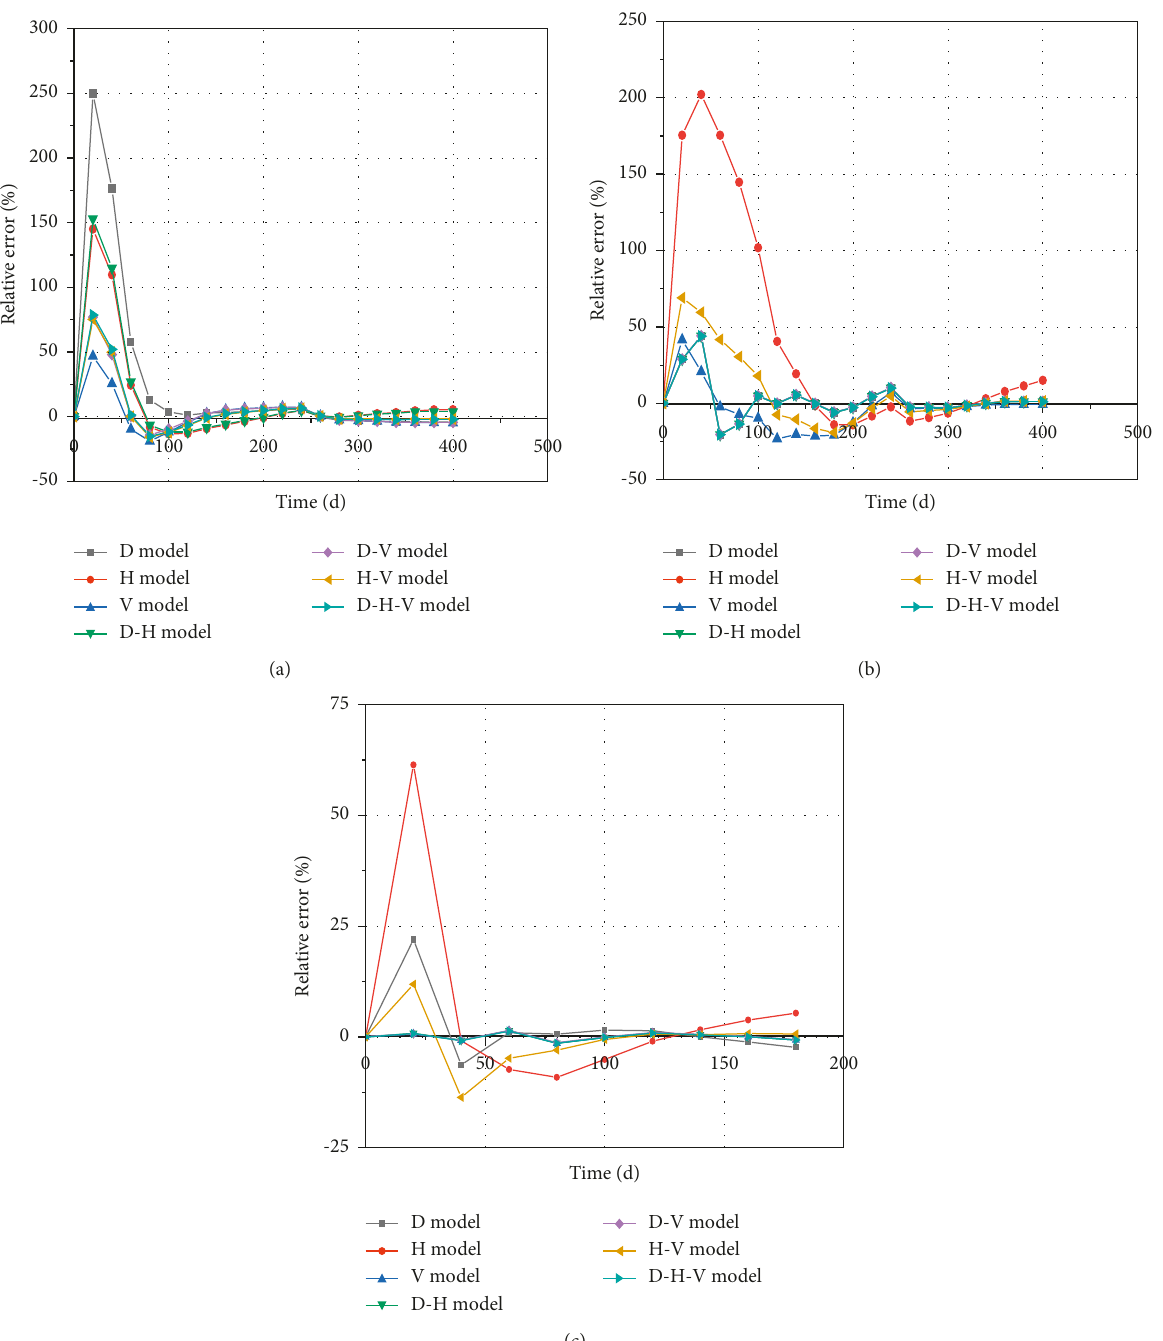
Figure 3: Observation time and relative error curves. (a) DK84 +771 section. (b) DK84 +821 section. (c) DK123 +960